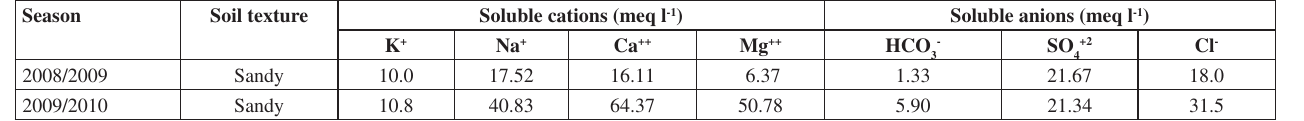
Table 2/A: Physical and chemical analysis of the experimental soil in 2008/2009 and 2009/2010 seasons Season